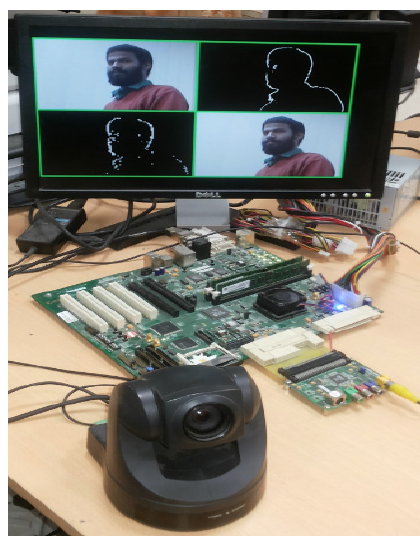
Figure 11. Complete Motion Detection System Setup.